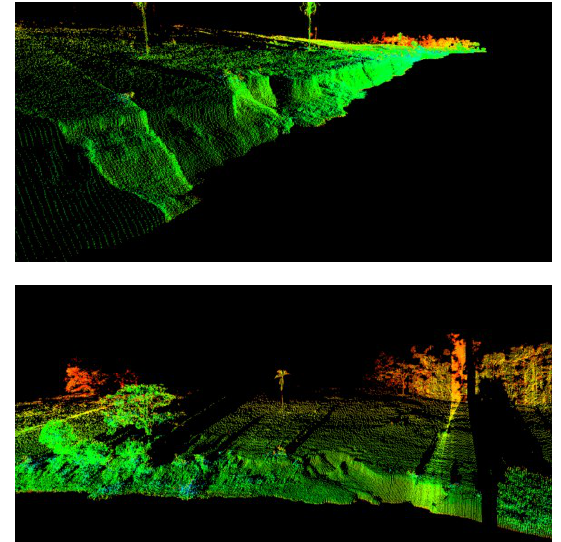
Figure 4. Examples of point clouds acquired with the mobile laser scanner.